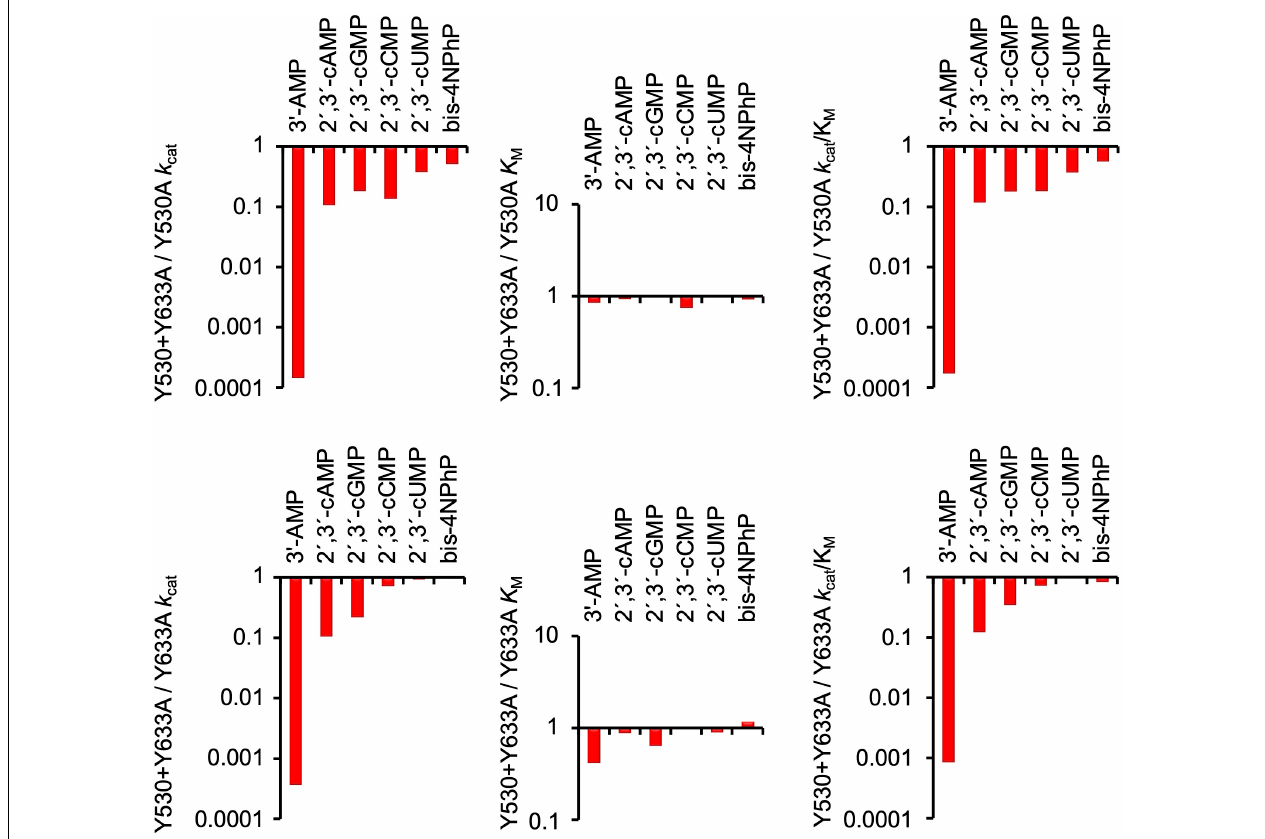
FIGURE 5 | Comparison of effects of double SntA mutant Y530A + Y633A with single mutants Y530A and Y633A. Absolute values of k cat , K M , and k cat / K M for double mutant are shown in Table 4 . Panels show in log scale ratios of these data vs. parameters of single mutants ( Tables 2 , 3 ).